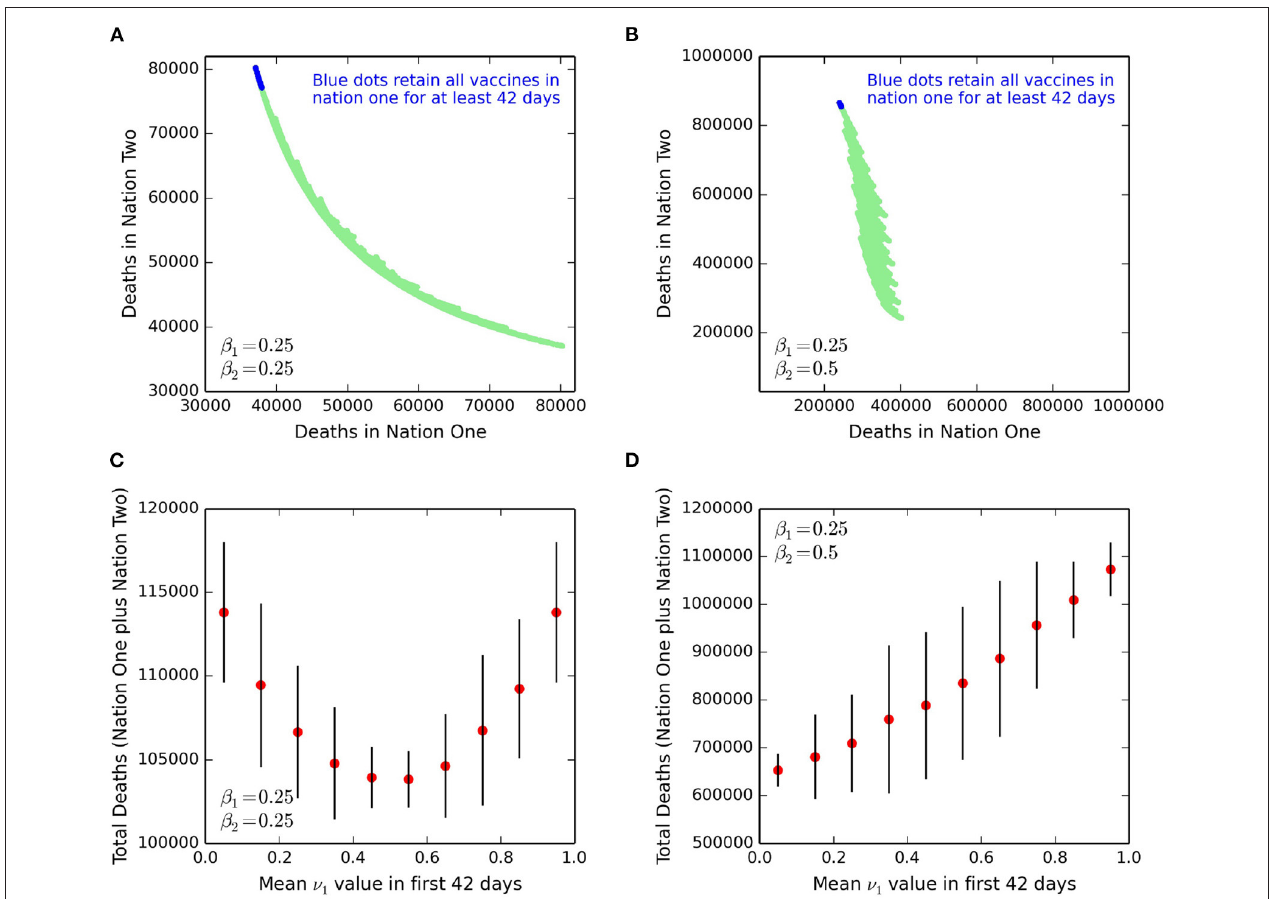
FIGURE 3 | Total deaths in both nation one and nation two at the time of complete vaccination of both nations. Each point in the top row corresponds to a single set of fortnightly policy decisions on vaccine sharing. (A) For parameter values and initial conditions presented in Table 1 . (B) Asymmetric case where virus transmission is more prevalent in nation two, and so with β 2 = 0.5. In (B) , both axes are scaled identically to highlight the different death rates. The blue dots are where nation one retains all vaccines (i.e., ν 1 ≡ 1) for at least the first three fortnightly periods. In (C) , we return to the same parameters and simulations shown in (A) , but now show the total deaths (those of nation one plus nation two), and disaggregated by the mean value of vaccine sharing, ν 1 in the first 42 days. The red dots are the mean values for each “bin” of size 0.1 for ν 1 , and the vertical lines are ± two standard deviations. (D) Identical to (C) , except for the parameter values of (B) i.e., with high virus transmission in nation